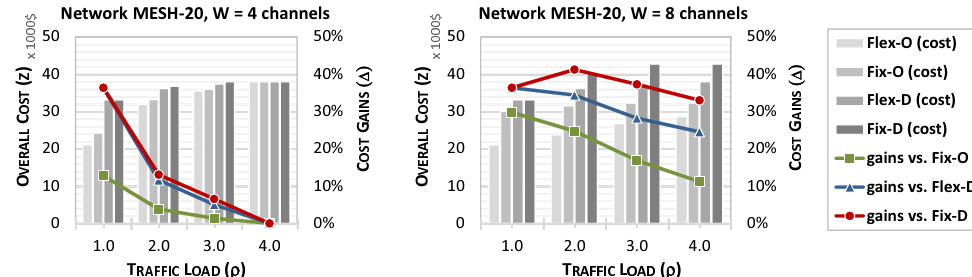
Figure 7. Overall network cost in different scenarios (bars) and cost gains achieved with flex-O vs. reference scenarios (lines) as a function of traffic load ( ρ ) for different WDM capacities ( W ) in MESH-20.